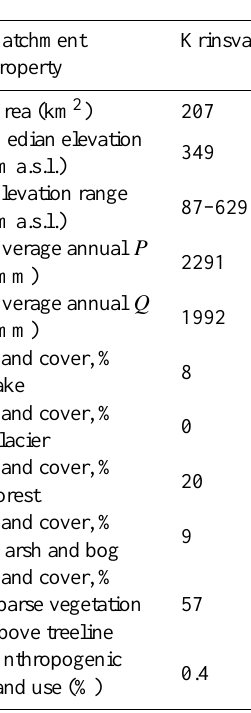
Figure 1. The location of the six study catchments and their current flood regime demonstrated by flood roses indicating the magnitude and timing of observed annual maximum floods. Values are given as specific discharge (mmday − 1 ). Note that secondary annual flood peaks can occur during contrasting seasons. Table 1. Characteristics of the six study